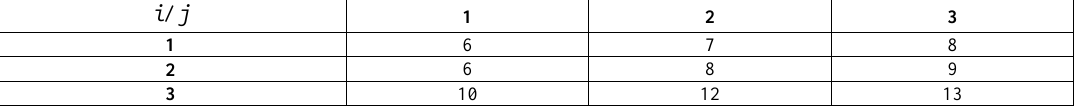
Table 3. Fixed capacitated restriction on the route for both the